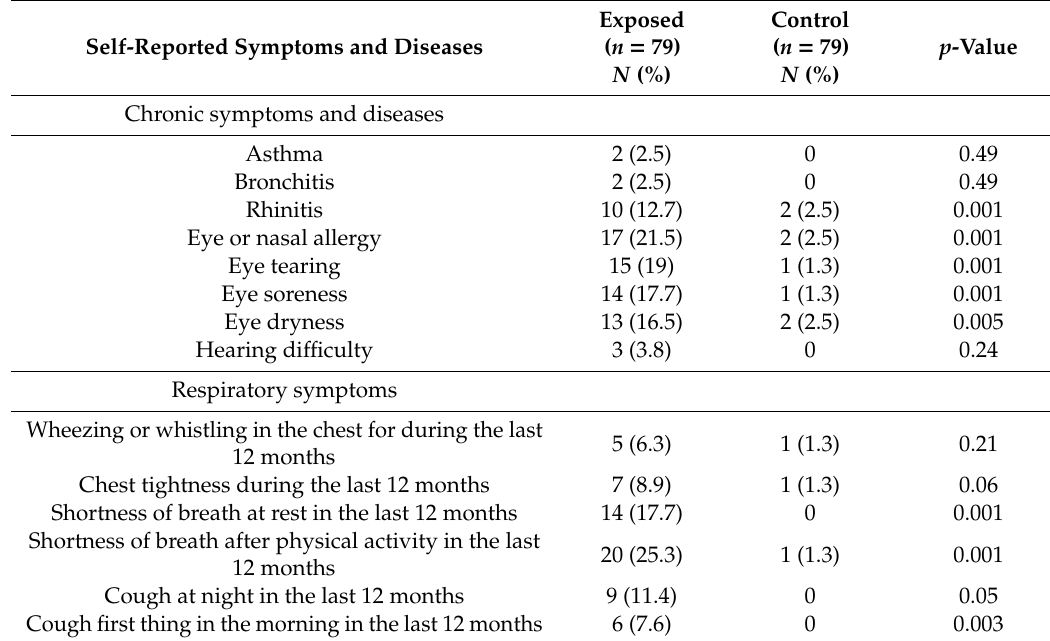
Table 3. Self-reported prevalence of general respiratory symptoms and diseases among the two study